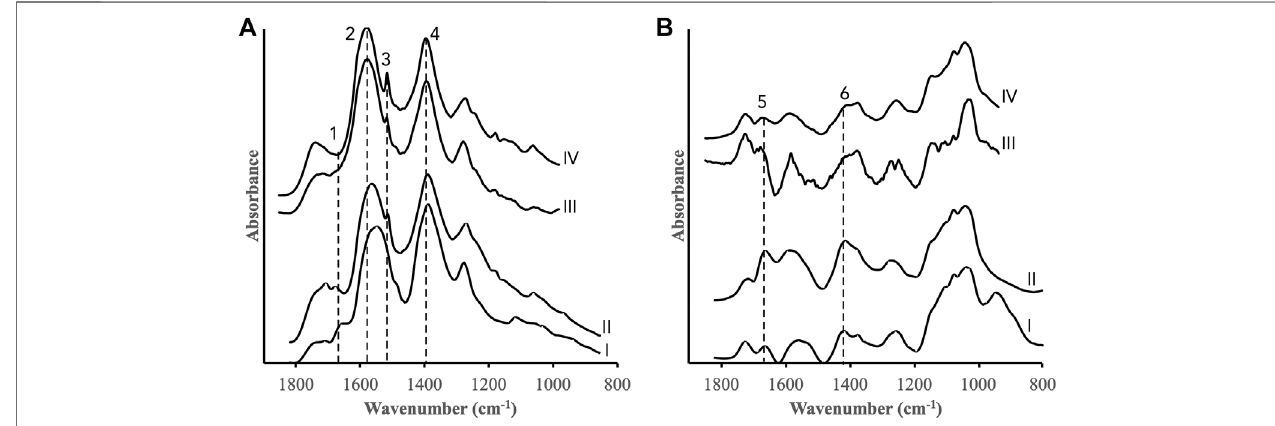
FIGURE 3 | IR spectra collected after 1,440 min reaction time between the iron oxides and (A) DOM mod-EtOAc and (B) DOM mod-H2O . Ferrihydrite experiments performed at TOC concentration of (I) 12 μ mol m − 2 , and (II) 60 μ mol m − 2 , and goethite experiments at (III) 12 μ mol m − 2 and (IV) 60 μ mol m − 2 . The vertical dotted lines highlight bands discussed in the text. These bands likely have predominant contributions from: 1) carbonyl-like modes (1,660 cm − 1 ); 2) asymmetric carboxyl stretch (1,565 cm − 1 ); 3) aromatic skeleton mode (1,515 cm − 1 ); 4) symmetric carboxyl stretch (1,380 cm-1); 5) carbonyl-like mode (1,660 cm − 1 ); 6) symmetric carboxyl stretch (1,415 cm − 1 ) (see Supplementary Table S2 for an overview of the band assignments). The spectra have been shifted in the y-direction for the sake of